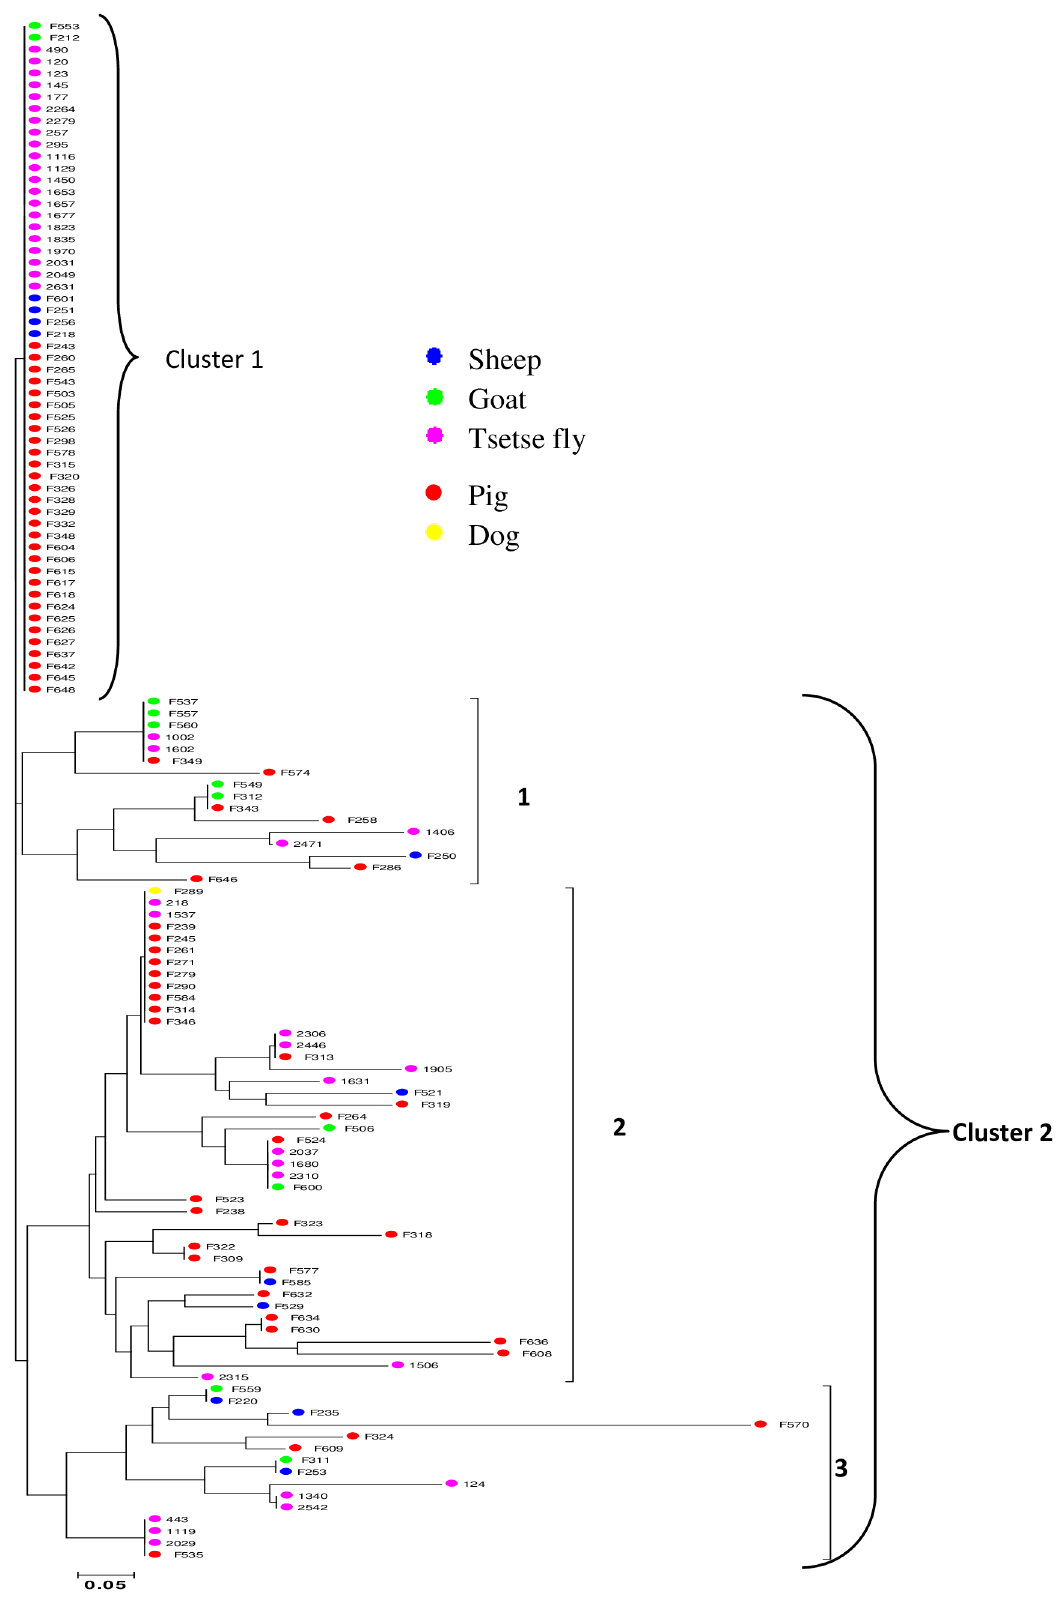
Figure 2. NJ Tree based on Cavalli-Sforza and Edwards chord distance matrix of T. congolense “ forest type ” circulating in tsetse fl ies and domestic animals of